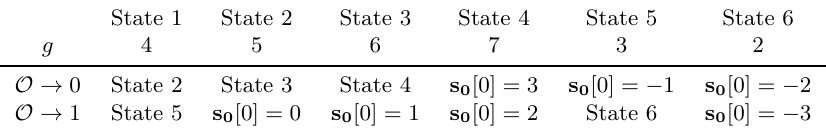
Table 1: Selections of g and the corresponding